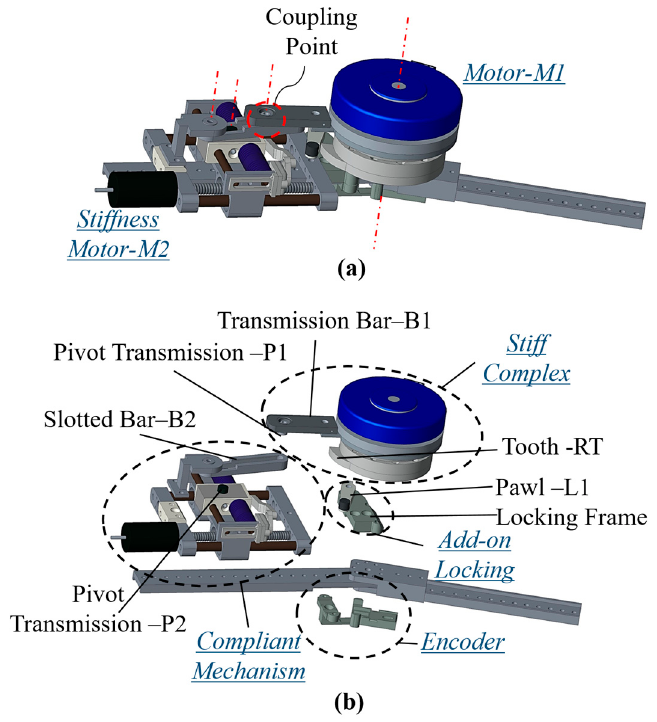
Figure 2. The adjustable rigidity with embedded sensor and locking mechanism actuator (ARES-XL) joint mechanics: ( a ) computer-aided design (CAD) drawing of ARES-XL; ( b ) CAD-explosion of the main components of ARES-XL: stiff complex, compliant mechanism, add-on locking, and position encoder.